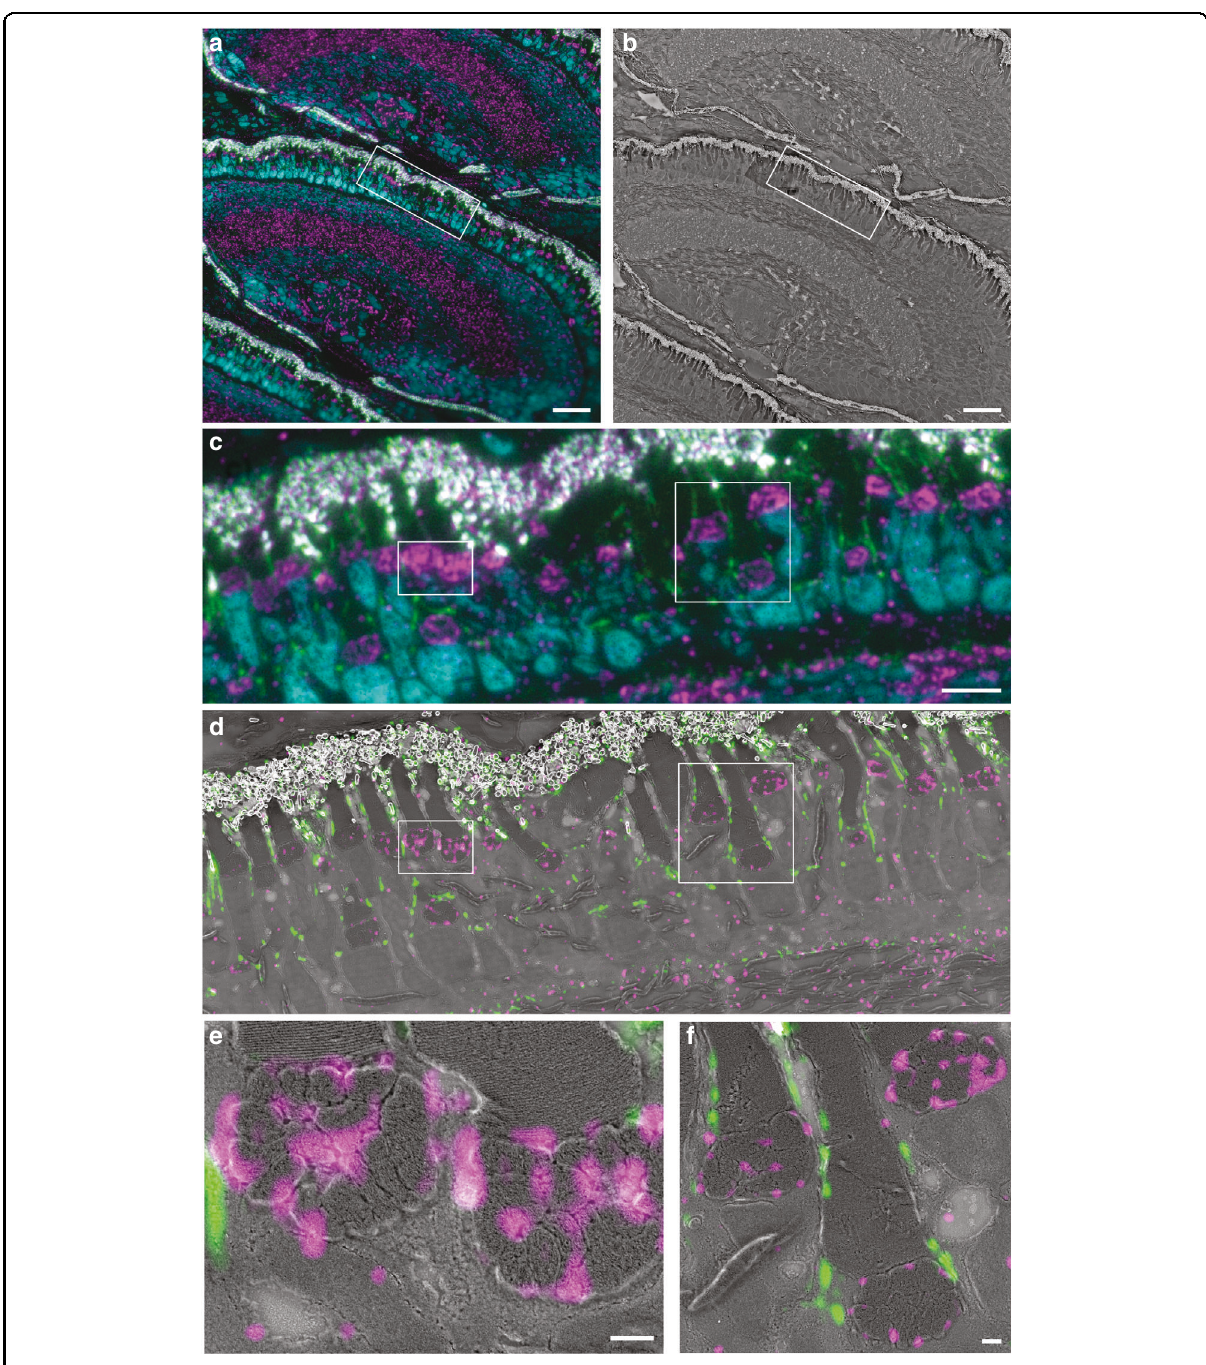
Fig. 5 Chip-based CLEM imaging of a 110nm thick zebra fi sh retina cryosection prepared by Tokuyasu method on a 600µm wide optical waveguide. a Diffraction-limited chip-TIRFM image. In magenta, mitochondrial clusters immunolabeled with rabbit anti-Tomm20 protein (primary antibody) and Alexa Fluor 647-conjugated donkey anti-rabbit (secondary antibody). In green, actin segments labeled with Texas Red-X Phalloidin. In cyan, nuclei labeled with Sytox Green. b Scanning electron microscope image of the same region shown in ( a ) scanned at 30nm pixel size. c high-magni fi cation image of the white frame in ( a ) showing the diffraction-limited chip-TIRFM signal of mitochondria, actin, and nuclei. d CLEM image of areas in frames ( a ) and ( b ). Scanning electron microscope image acquired at 4nm pixel size correlates with the MUSICAL images of mitochondria (magenta) and actin (green). e CLEM image of the white region in ( d ). MUSICAL image of the Tomm20 signal (magenta) in the outer membrane of mitochondria correlating with the morphology of the complex clusters of mitochondria. The tightly packed membranes of the outer segment are clearly recognized. f CLEM image of MUSICAL-processed actin signal along with the outer segments (green) and three mitochondria clusters. The MUSICAL signal in ( d – f ) were gamma-corrected to increase the contrast of the actin ( γ = 1.2) and the Tomm20 signal ( γ = 1.1). Scale bars a , b 20µm, c , d 5µm, e , f